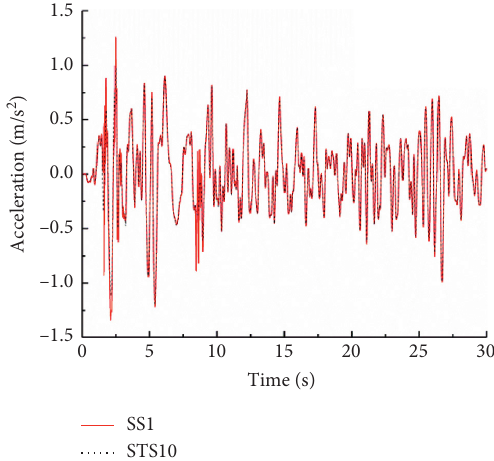
Figure 12: Acceleration at the top of the station.